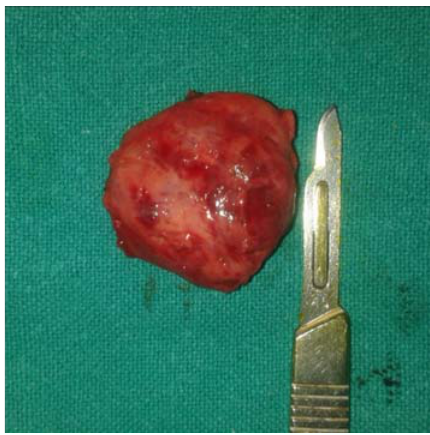
Figure 3: Excised (surgical)